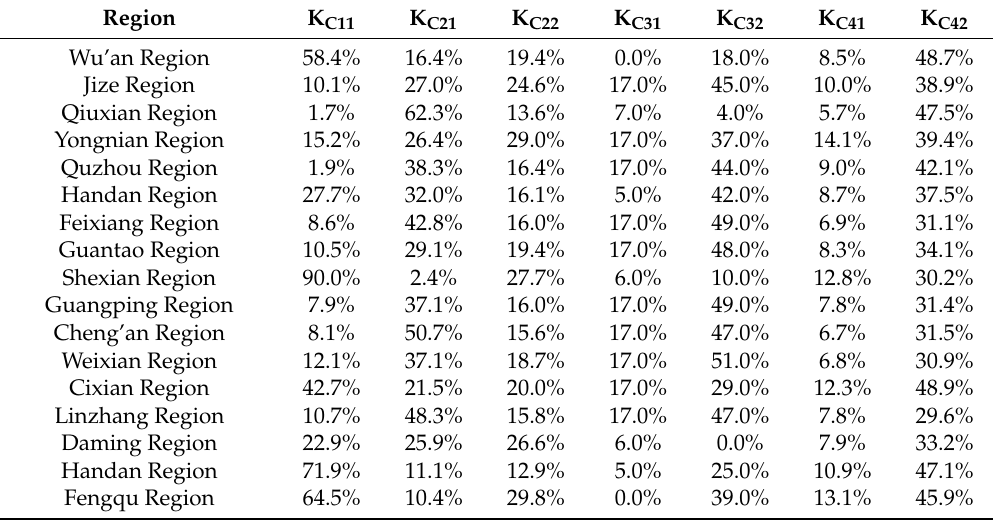
Table 10. Potentials of the factors to be improved for a higher contribution to SWA in normal hydrological